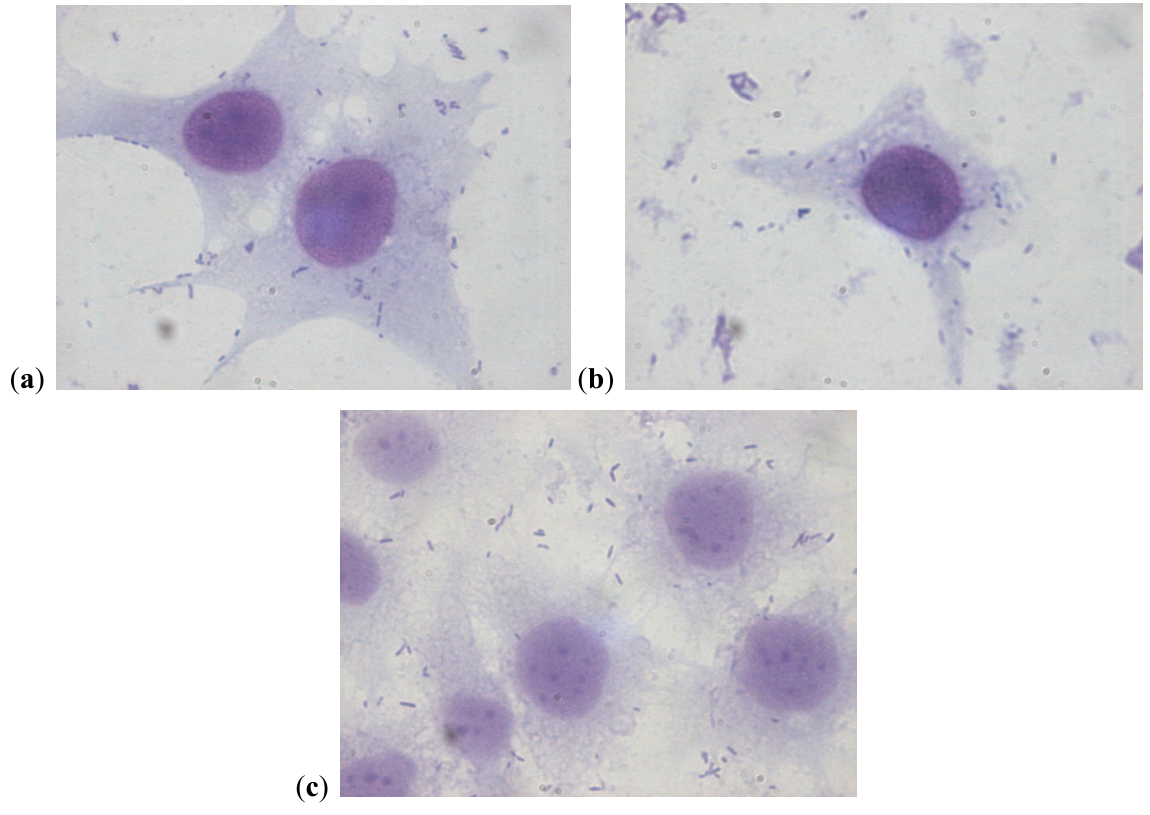
Figure 4. ( a – c ) Strains of P. mirabilis adherent to cells after treatment with PACs at the concentration of 50 µg/mL. The lower number of adherent bacteria can be clearly seen.